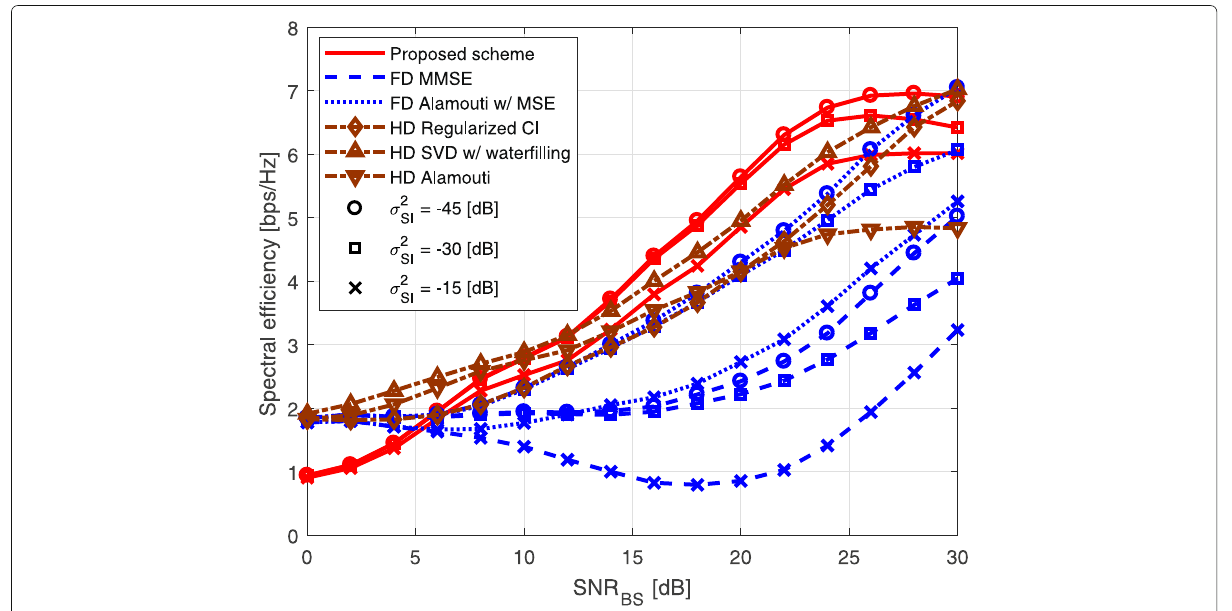
Fig. 4 The sum spectral efficiencies of the proposed scheme and the existing schemes according to BS transmission power